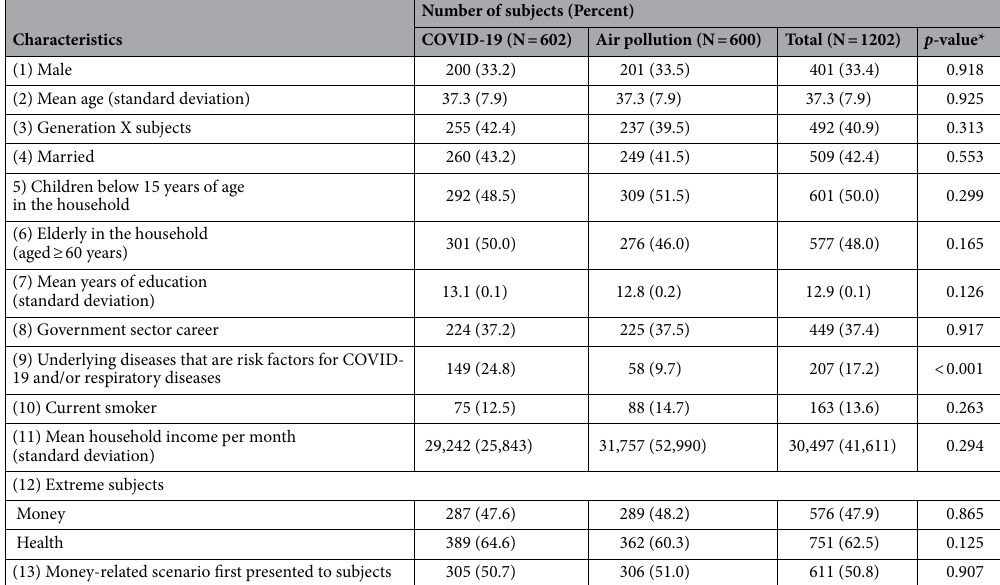
Table 2. Socio-demographic characteristics. Remark: * Statistical analysis using independent